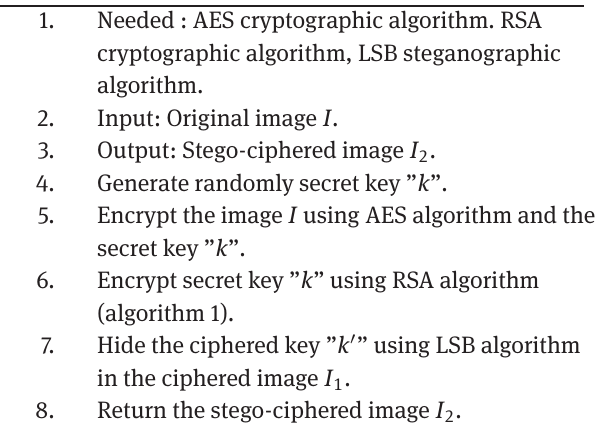
Algorithm 2: Proposed encryption scheme